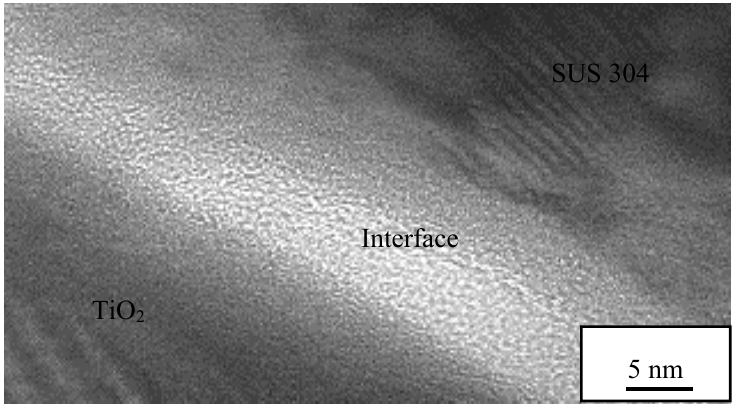
Figure 9. High-magnification images of the TiO 2 /1000 °C annealed SUS 304 interface at the rebound region, R.